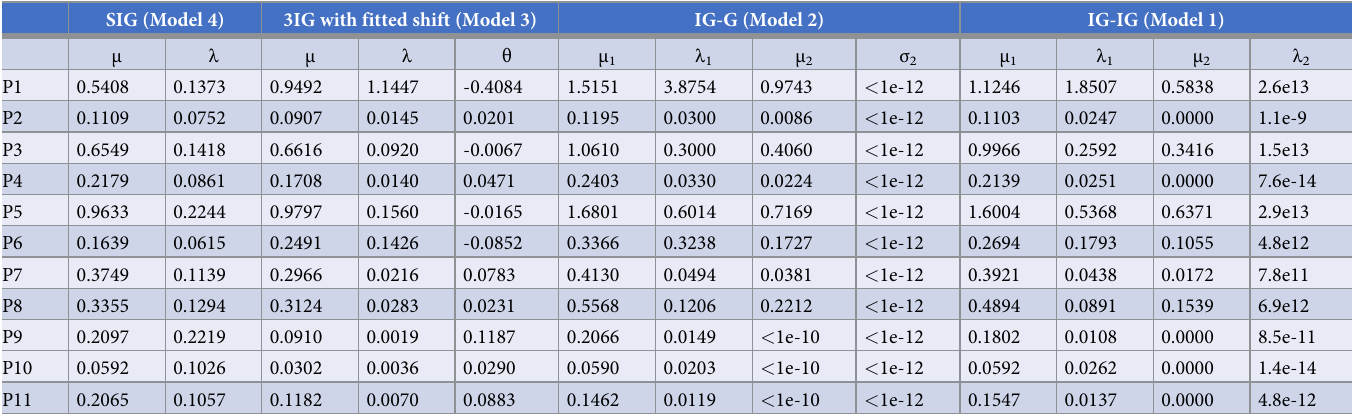
Table 5. Fitted parameter values for Models 1–4 for propofol sedation